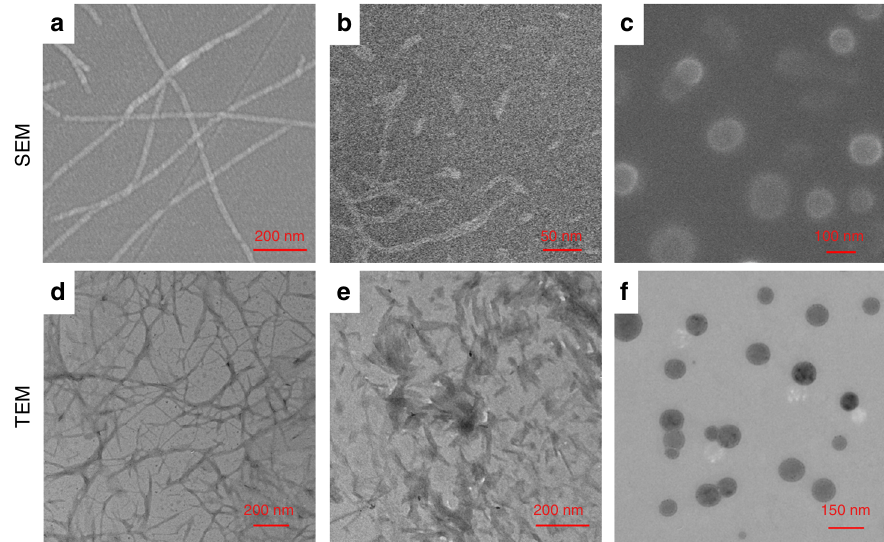
Fig. 3 Programmable supramolecular peptide self-assembly process. SEM and TEM images: a, d PA; b , e P5 + PyP at 25 °C; c, f P5 + PyP at 45